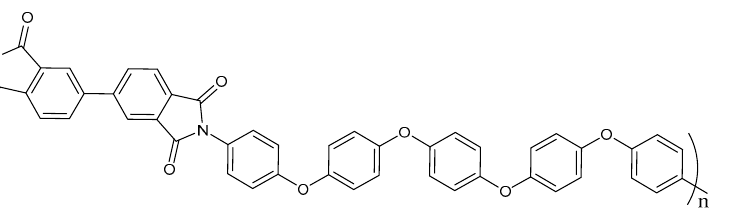
Figure 1. The chemical structure of the repeating unit of the thermoplastic PEI BPDA-P3